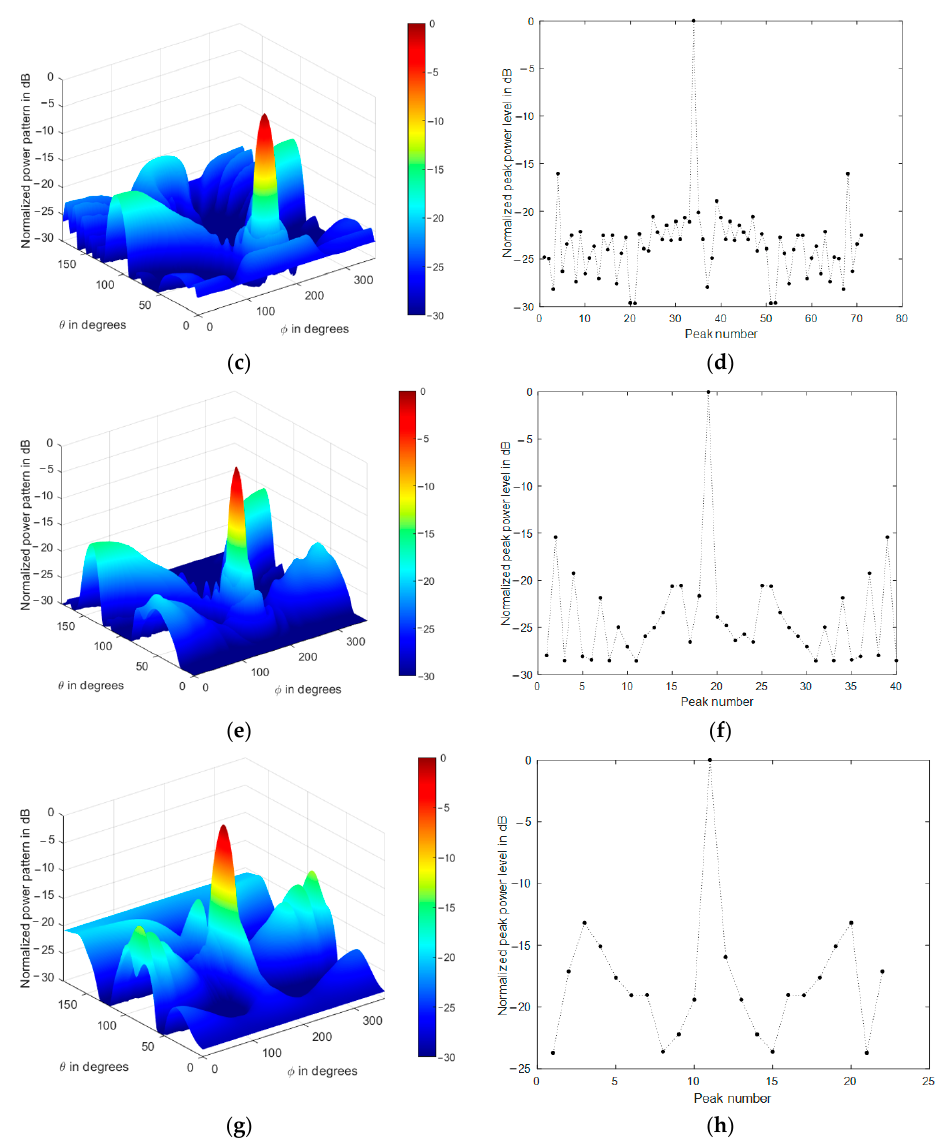
Figure 9. Normalized power pattern of spatially filtered CSC 4 ( a , c , e , g ) and the corresponding radiation peaks ( b , d , f , h ) at four different mainlobe directions (0°,180°), (30°,180°), (60°,180°), (90°,180°), respectively.